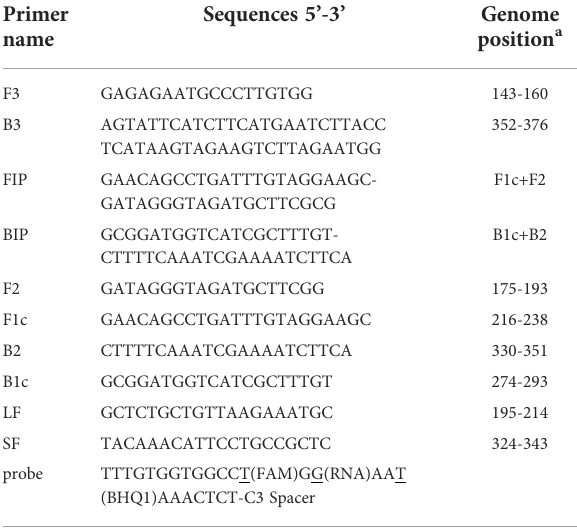
TABLE 2 Primers of the LP-LAMP method for the Streptococcus suis cps K